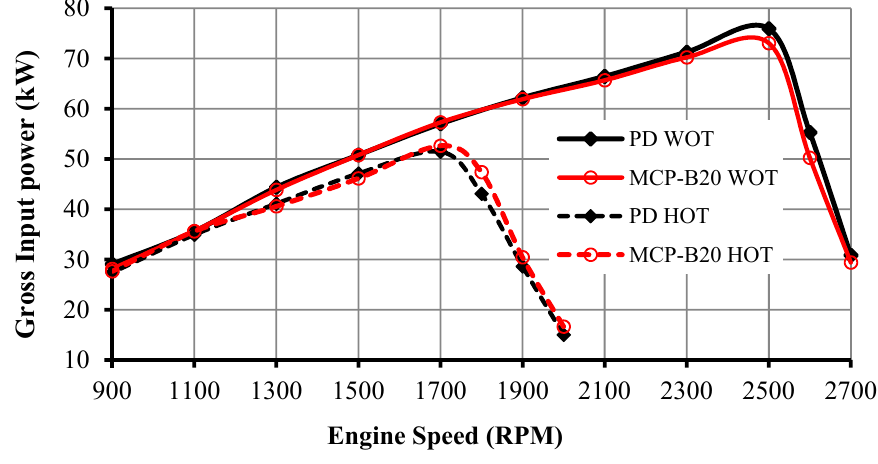
Figure 3. The relationship between tractor engine speeds (RPM) and engine gross input power (kW) for PD and MCP-B20.